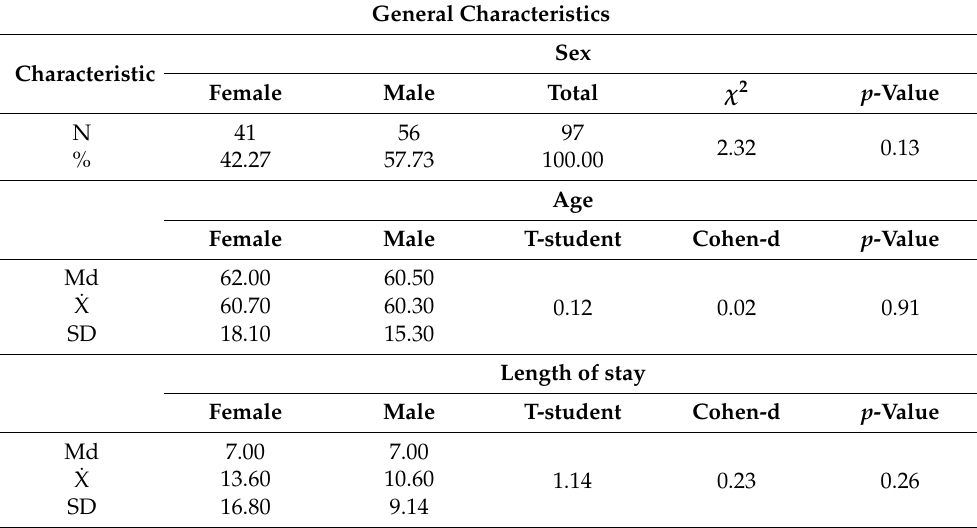
Table 1. Data related to sex, age, and length of stay for hospitalized patients with clinical suspicion of COVID-19. General Characteristics